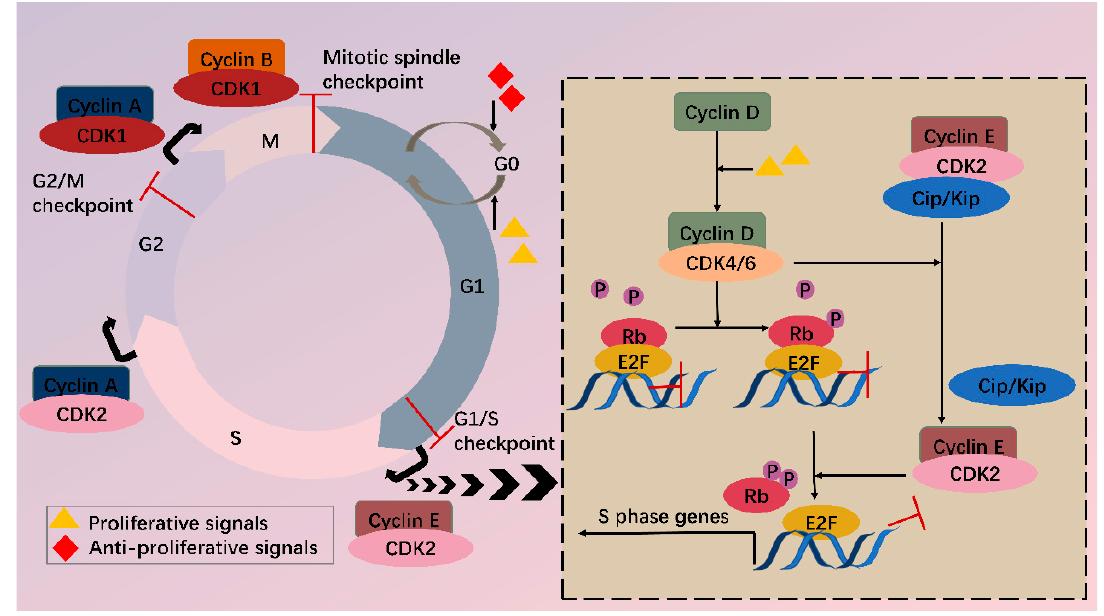
Figure 1. CDKs and cell cycle. Cell cycle consists of G1, S, G2 phase and mitosis. Independent of a cell cycle also exists a dormant G0 phase. Whether a cell steps into a cell cycle relies on balance between proliferative and antiproliferative signals. During a cell cycle, multiple CDKs are sequentially activated. In G1, activated CDK4/6 by cyclin D phosphorylate Rb, partially relieving inhibition of E2F by Rb. Meanwhile, CDK4/6 hijacks Cip/Kip proteins, which stimulate CDK2-cyclin E,